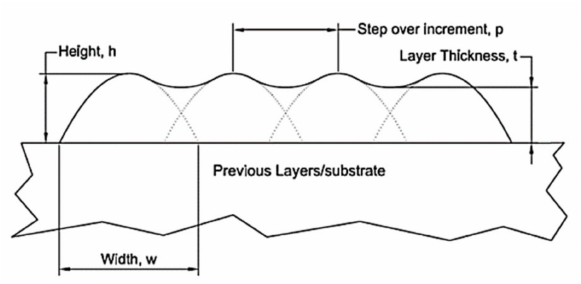
Figure 26. Multi bead profile. Reprinted with permission from Ref. [71]. Copyright 2011